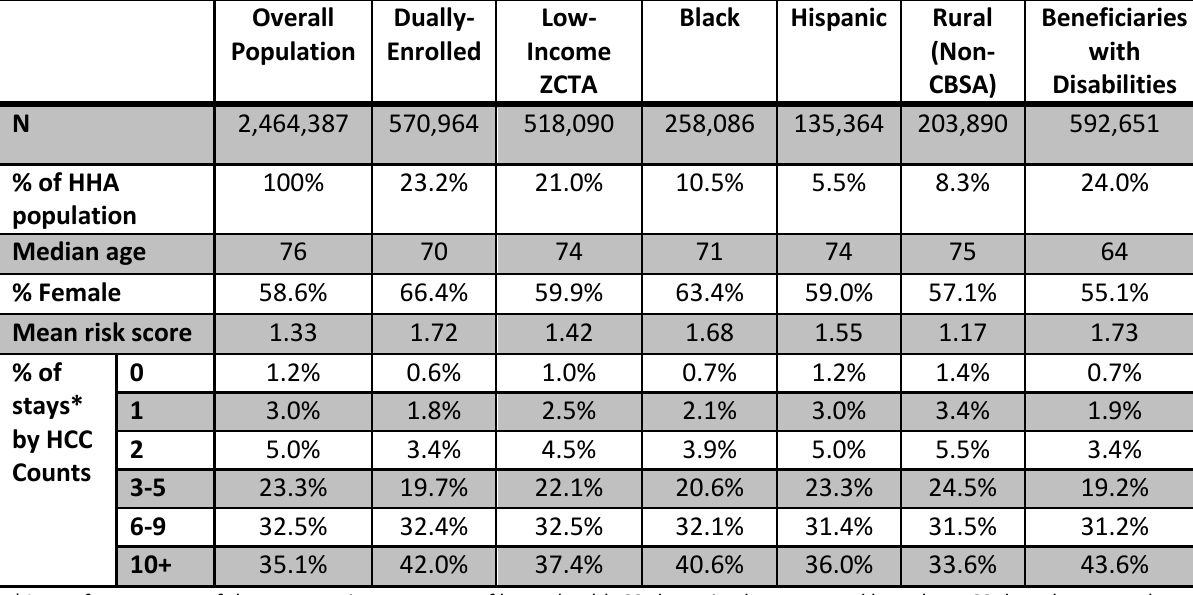
Table 13.1: HHA Beneficiary Population, Fiscal Year 2012-